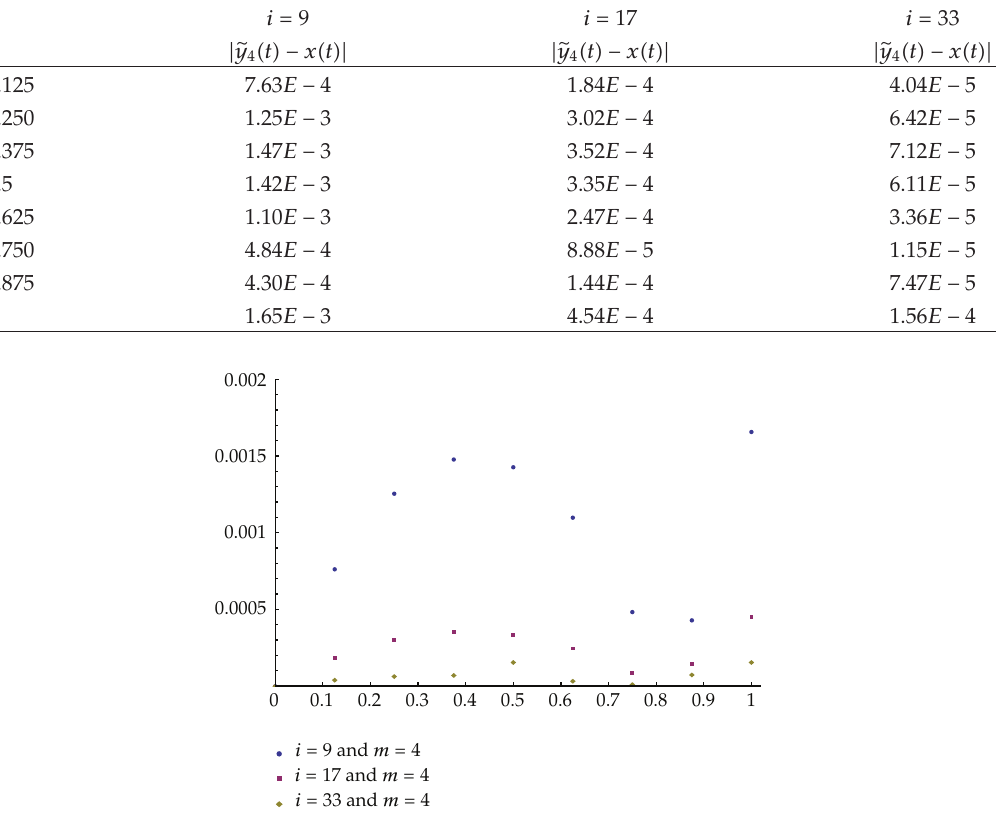
Table 1: Absolute errors for Example 4.1.